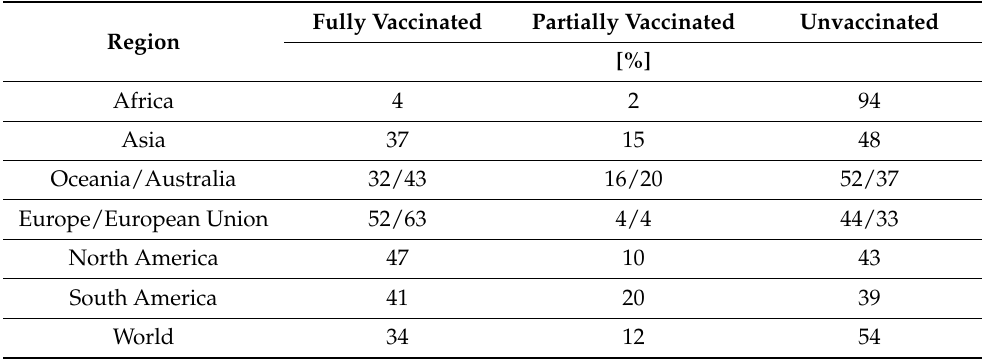
Table 1. The proportion of fully and partially vaccinated and unvaccinated individuals in different world by 1 October 2021. Based on [64]. Fully Vaccinated Partially Vaccinated Unvaccinated Region [%] Africa 4 2 94 Asia 37 15 48 Oceania/Australia 32/43 16/20 52/37 Europe/European Union 52/63 4/4 44/33 North America 47